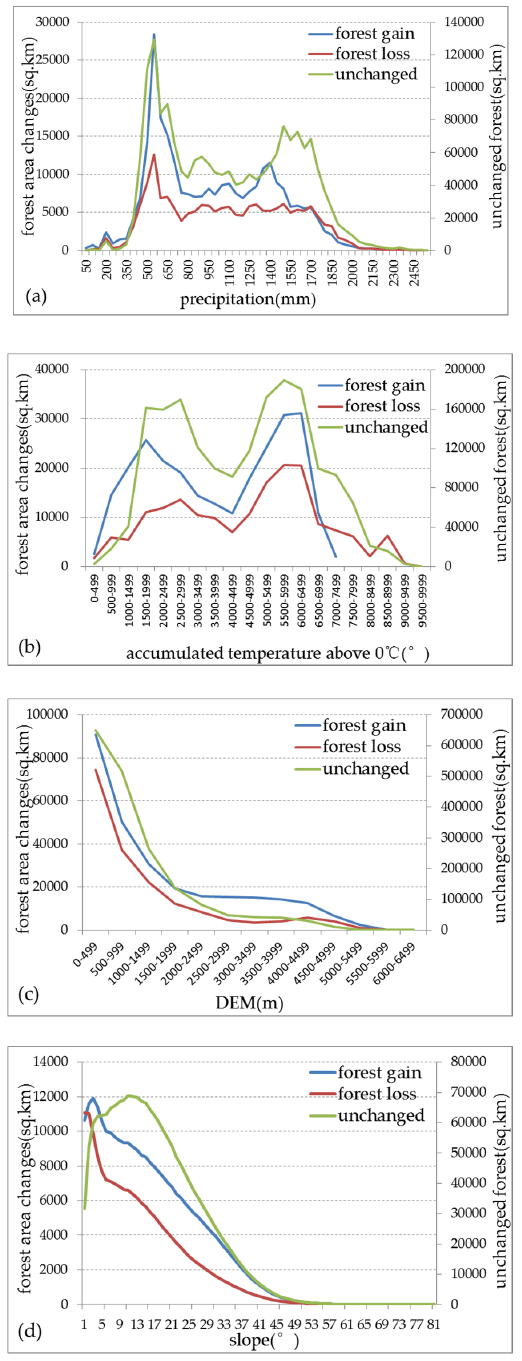
Figure 5. Relationships between forest area changes and natural factors.